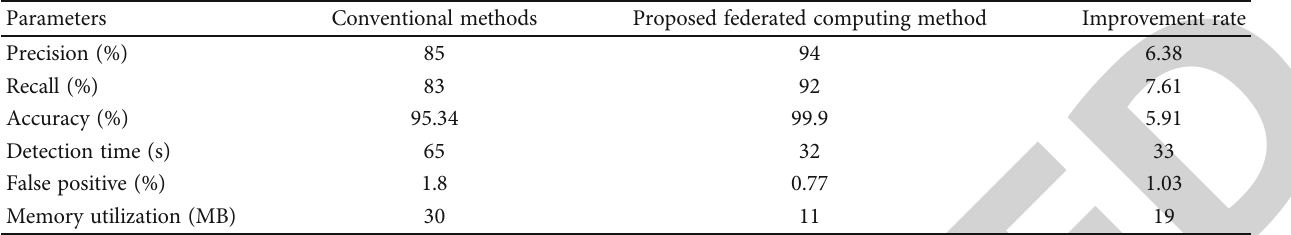
Table 2: Parameters.